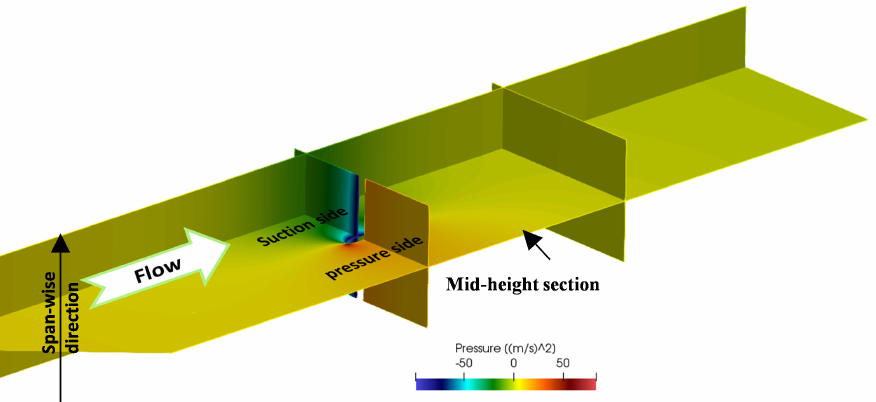
Figure 5. Pressure distribution in several cross-sections within the test section and around the